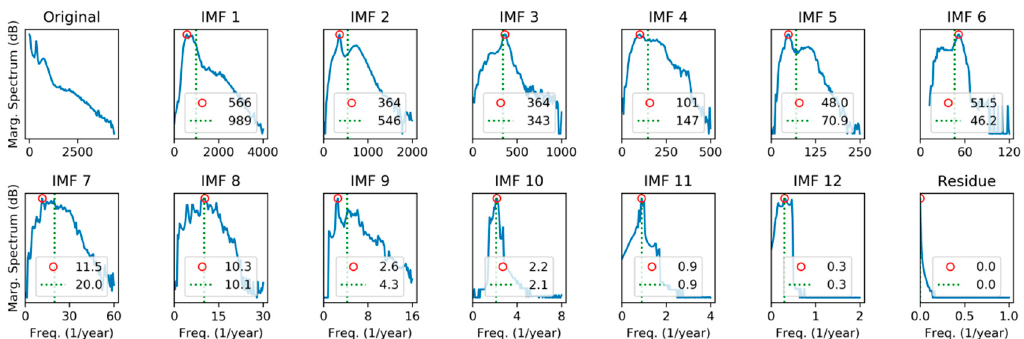
Figure 15. Spectral analysis of the electricity demand IMFs, using Marginal Hilbert Spectrum. Peak frequencies (red circle) and spectrum centroid (dashed green line) are marked.